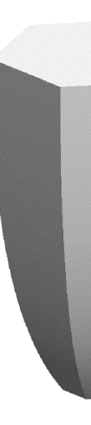
Figure 4. The appearance of a non-axisymmetric compound parabolic curve (NACPC).